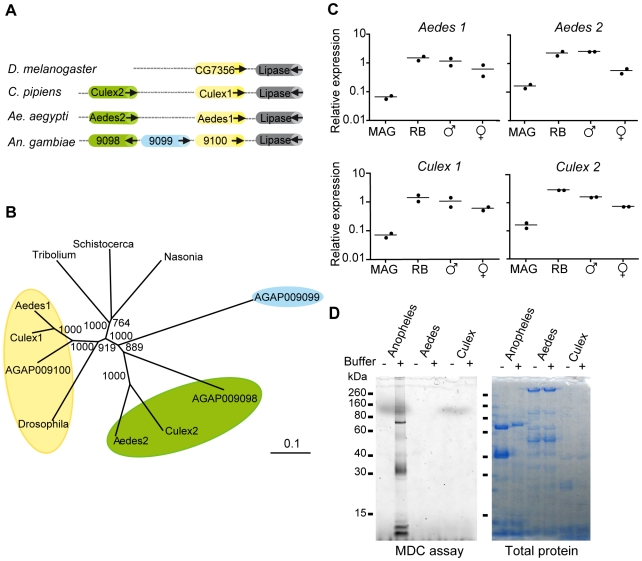
Insect species that do not make a mating plug do not possess an orthologue of AGAP009099.(A) Synteny map of Dipteran TGases. All insects included in the analysis possess one TGase (yellow) located just upstream of a conserved lipase. Mosquitoes possess a second TGase (green), while An. gambiae possess a third gene (blue), absent from Ae. aegypti and C. quinquefasciatus. Arrows indicate the direction of the reading frame. (B) Phylogenetic analysis of insect TGases. The bootstrap values of a 1,000 replicates are indicated. The scale bar represents the amino acid divergence. (C) qRT-PCR of culicine TGases. Neither the “ancestral” TGase (Aedes1, Culex 1) nor the mosquito-specific TGase (Aedes2, Culex2) shows high levels of expression in the MAGs. (D) TGase activity in the MAGs of three mosquito species. TGase activity was detected in the MAGs of An. gambiae (in Buffer “+”) but not Ae. aegypti or C. quinquefasciatus, despite the presence of protein in all samples.